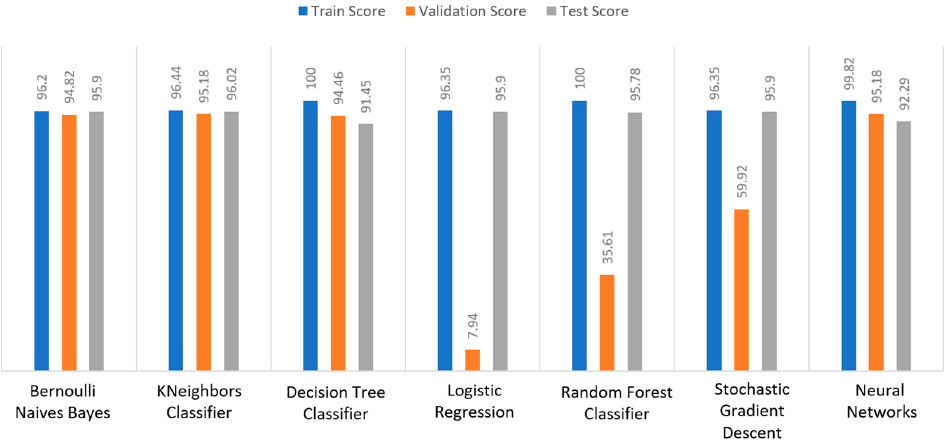
Figure 18. Train–validation–test score for stroke use case.